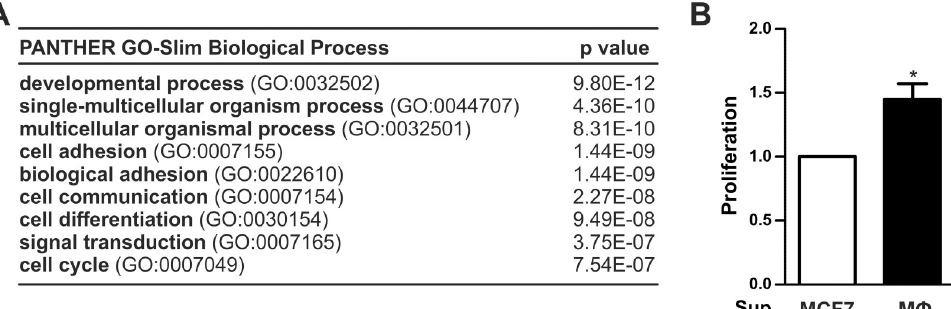
Fig 5. Functional impact of macrophages on breast tumor cells. (A) Enriched biological processes as determined by GO term analysis of the RNA seq data from M F -infiltrated and non-infiltrated tumor spheroids. (B) 1 x 10 4 MCF7 cells were seeded in a 96-well plate and incubated with supernatants from MCF7 cells or M F s. Proliferation was assessed using an IncuCyte S3 system and is presented as relative increase in confluency. Data are presented as means ± SEM (n > 3, � p <